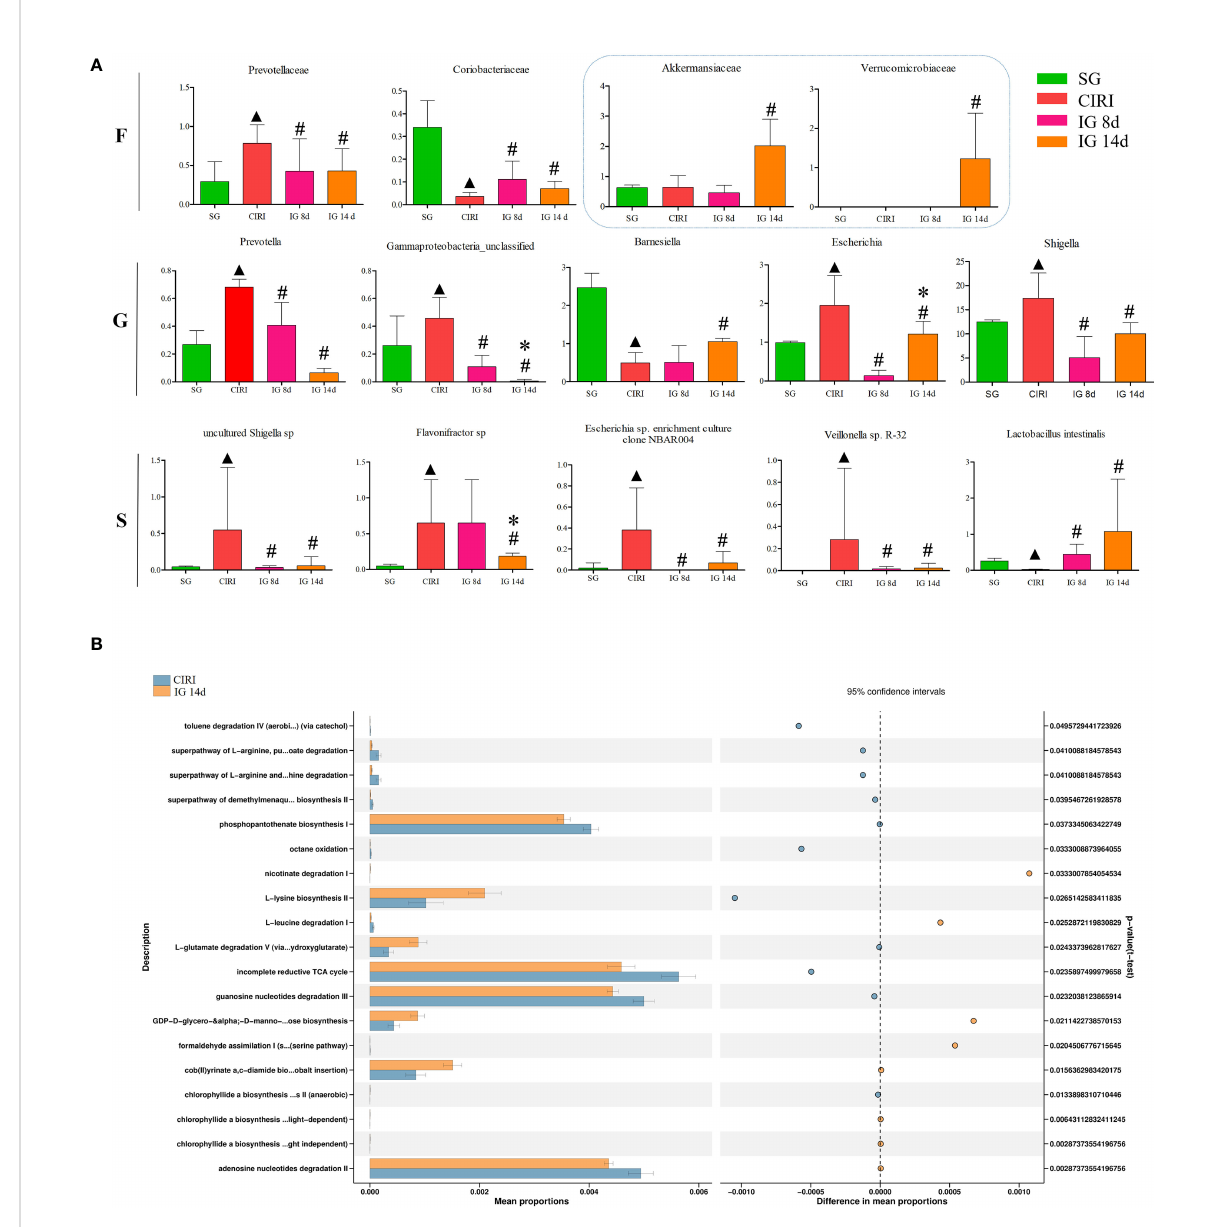
FIGURE 7 Differential bacteria and histogram of the KEGG gene function difference analysis related to CIRI after administration. Note: N = 6 rats per group, values are presented as mean ± SEM. ▲ P < 0.05 when compared with the SG, # P < 0.05 when compared with the CIRI, * P < 0.05 when compared with the IG 8d in (A) . There is the proportion of differences in functional abundance within the CIRI and the IG 14d, shown in the middle is the percentage of difference in functional abundance within the 95% con fi dence interval in (B)